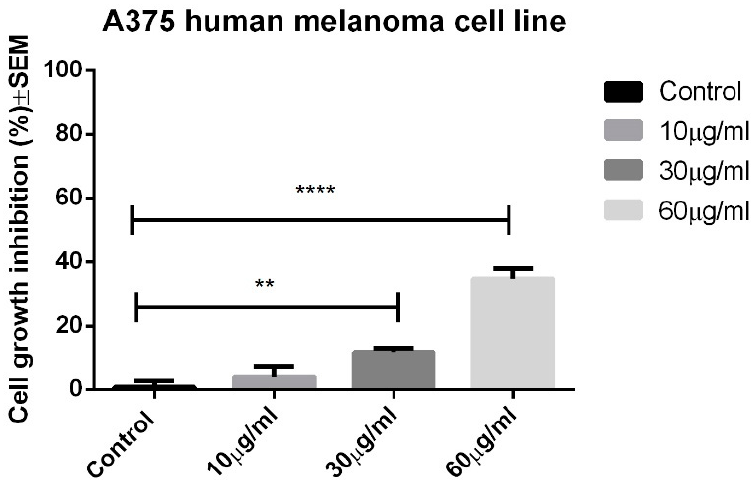
Figure 2. Antiproliferative potential of the OB extract against the A375 human melanoma cell